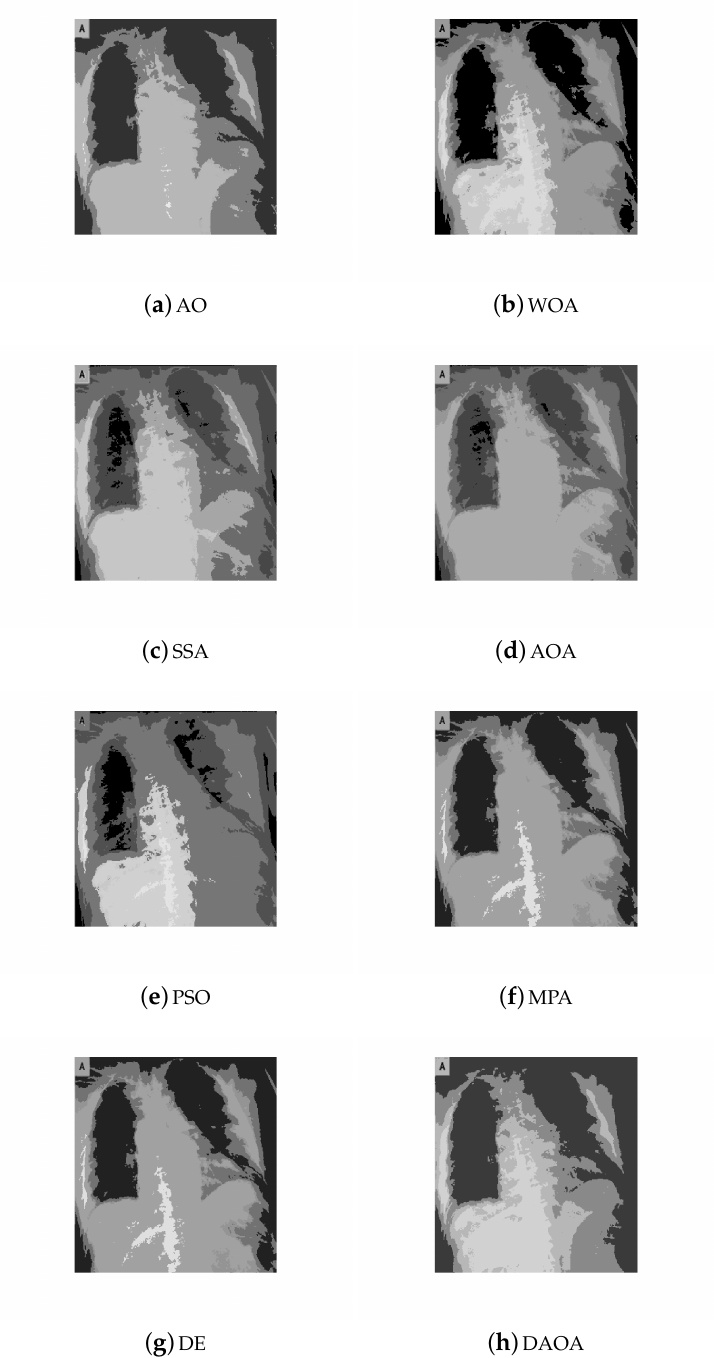
Figure 9. The segmented image (Test 8) by the comparative methods when the threshold value is